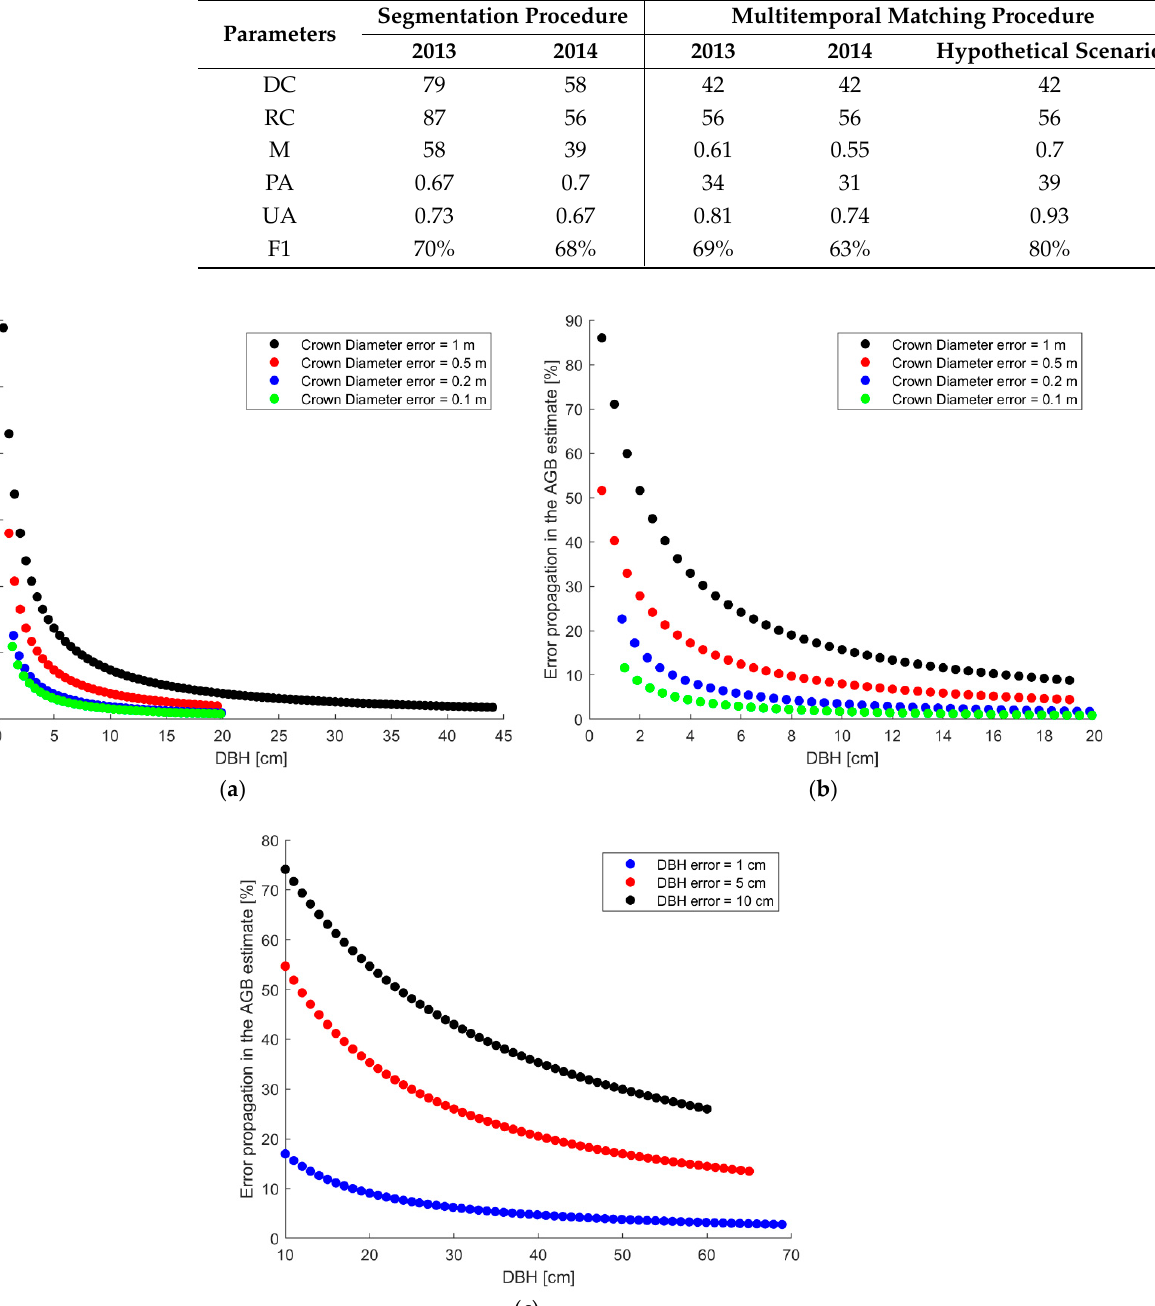
Figure 5. the error propagation of ( a ) Equation (1), ( b ) Equation (2), and ( c ) Equation (5) evaluated in percentage terms. ( a , b ) Error propagation with an error bias in the estimated crown diameter. ( c ) Error propagation with an error bias in the estimated DBH. ( c ) Error propagation with an error bias in the estimated